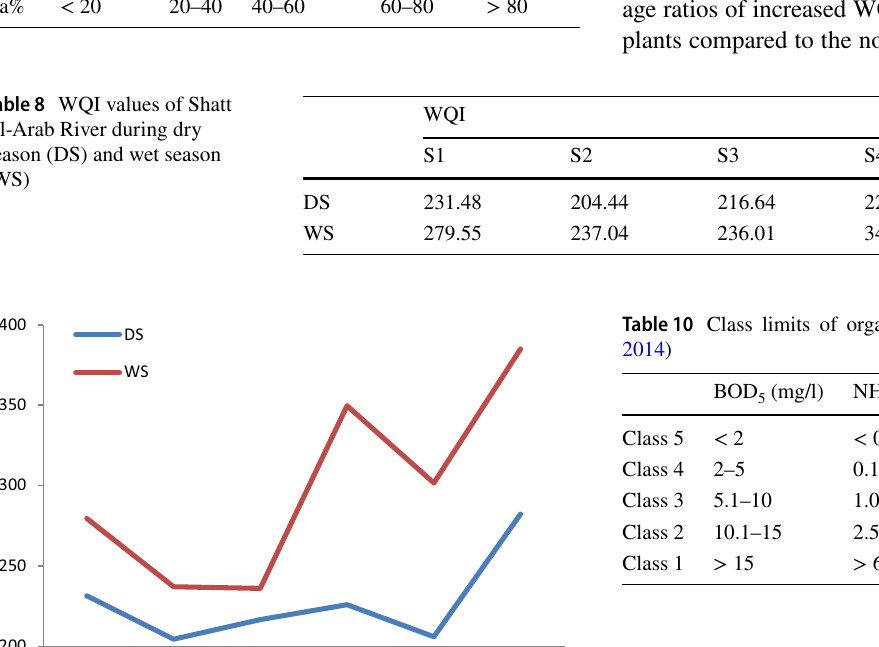
Table 7 Water class based on Na + percentage ratio (Wilcox 1995) Class